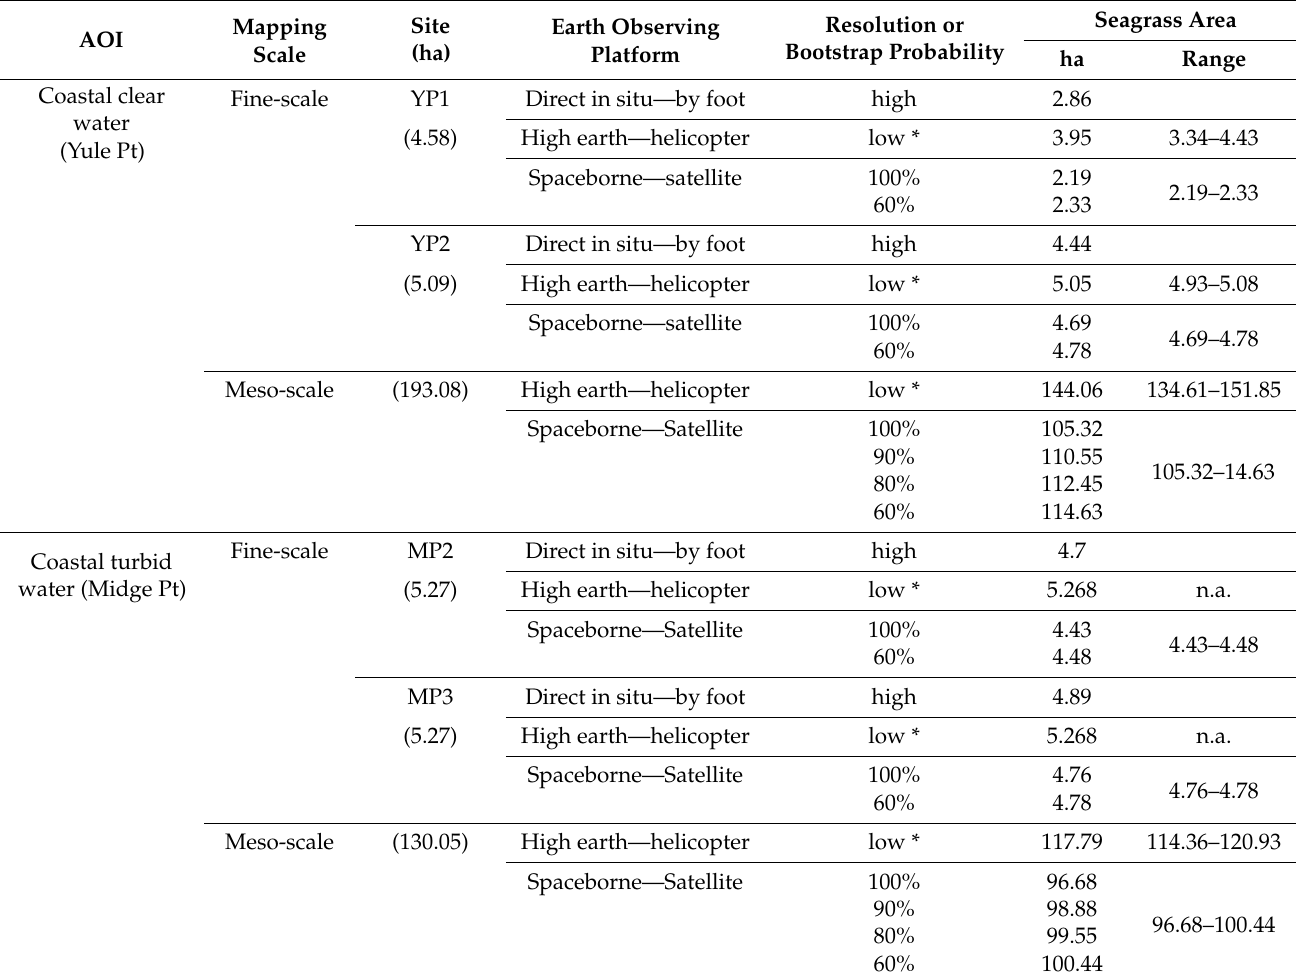
Table 6. Area of seagrass (hectares) mapped within each AOI in 2017 using different earth observing platforms and approaches to create fine- and meso-scale spatially explicit seagrass maps for coastal clear and turbid water habitats in the GBRWHA. The range in seagrass area is based on estimate of reliability (*) or bootstrap probability. n.a. indicates a boundary could not be delineated within the AOI due to the type of earth observing platform